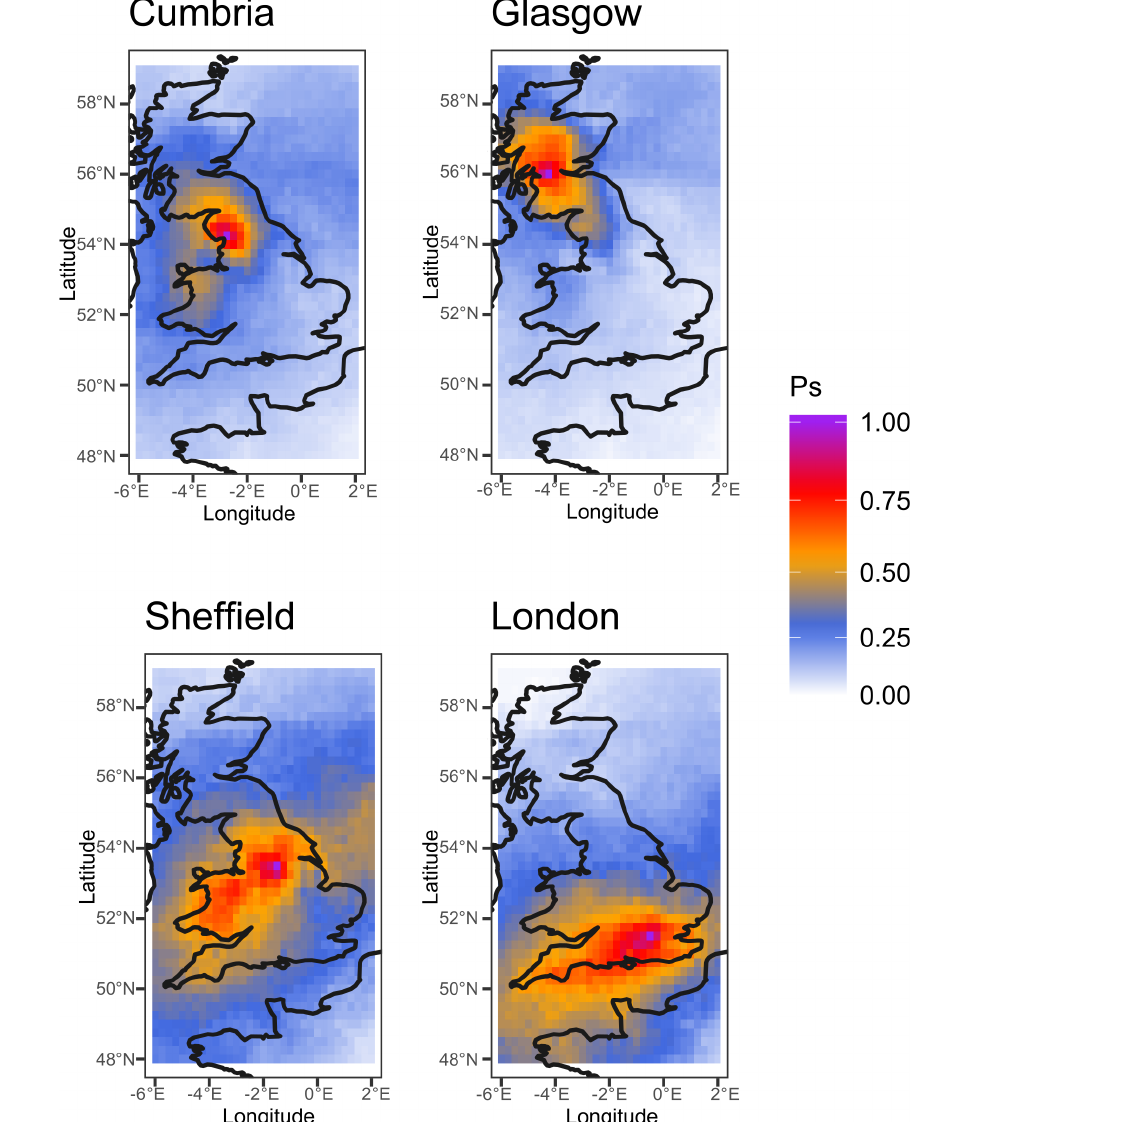
Figure A6. Spatial dependence of compound wind–rain occurrence between different sites. P s is the probability of each grid cell in the study area to be in a compound wind–precipitation cluster, knowing that a given cell of reference is in a compound